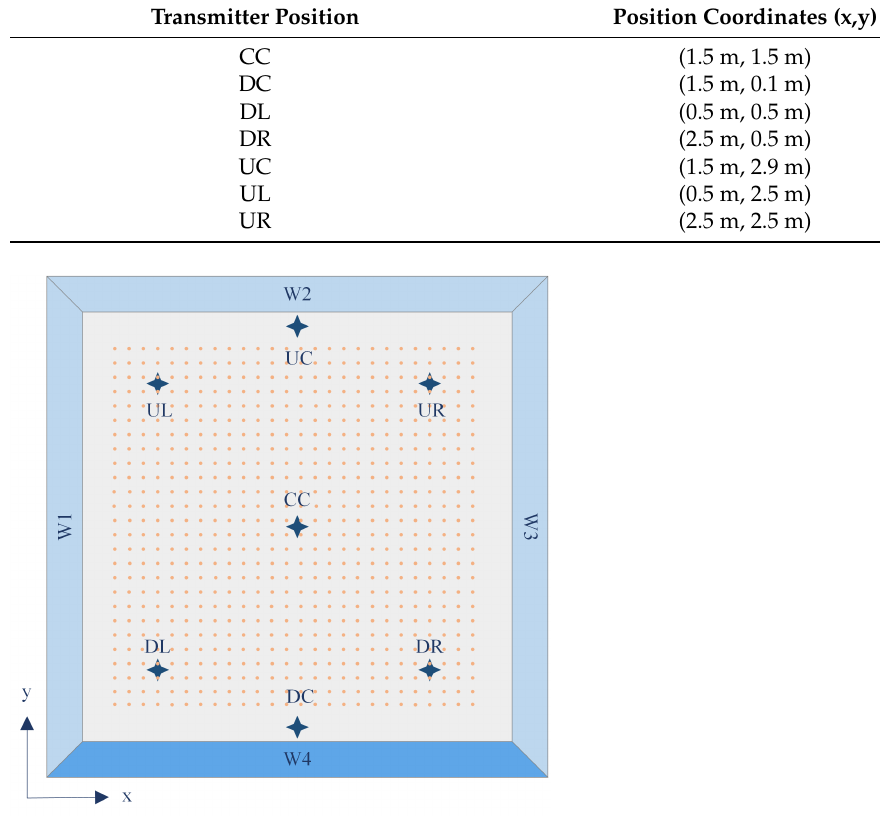
Figure 4. Transmitters (stars) and receivers